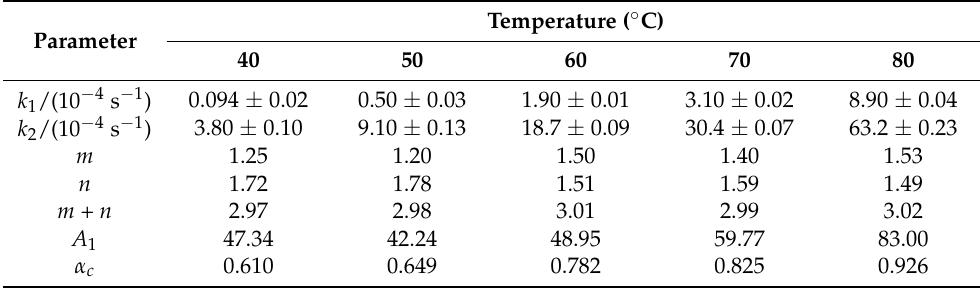
Table 2. Kinetic constants, reaction orders for the autocatalytic and n -th order mechanisms, and values for A 1 and α c , according to Equation (3), at different curing temperatures. Temperature ( ◦ Parameter